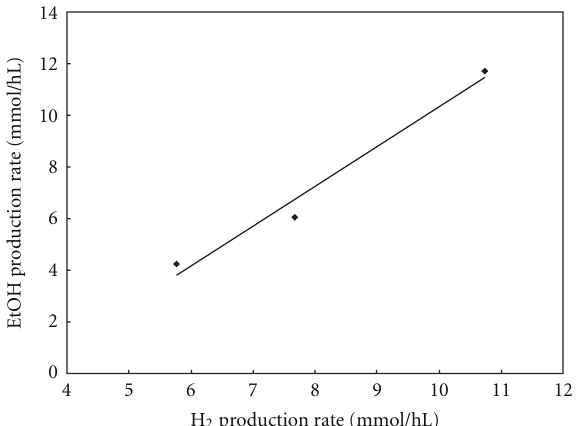
Figure 4: Composition of H 2 and ethanol production rate in CSTR using the carbon substrate of molasses (symbols: experimental data; line: linear regression of data to indicate the trend).